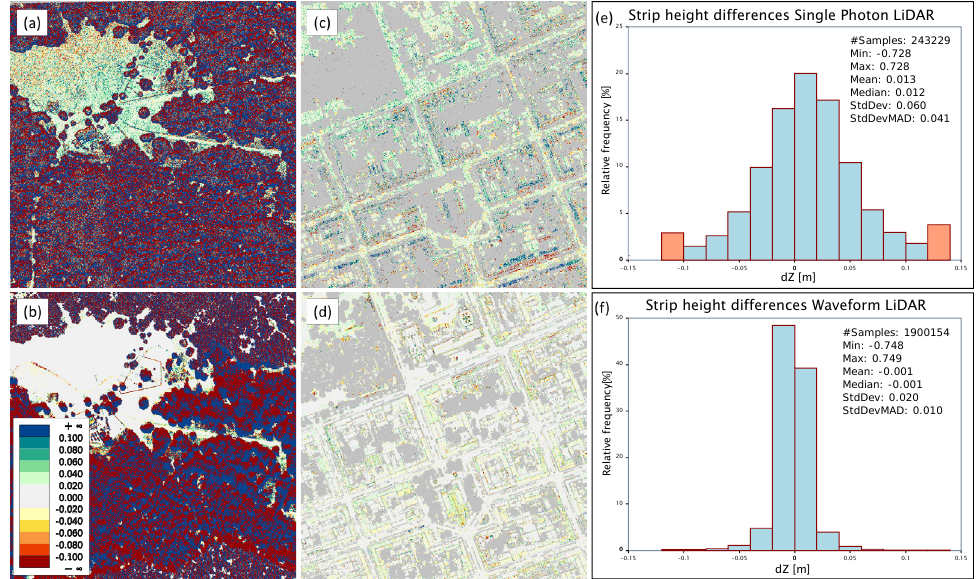
Figure 8. Strip height differences [m]: upper row: SPL, lower row: Waveform LiDAR; (a+b) forest test area unmasked, (c+d) city test area, smooth surface parts only, (e+f) Histograms of strip differences corresponding to (c+d)